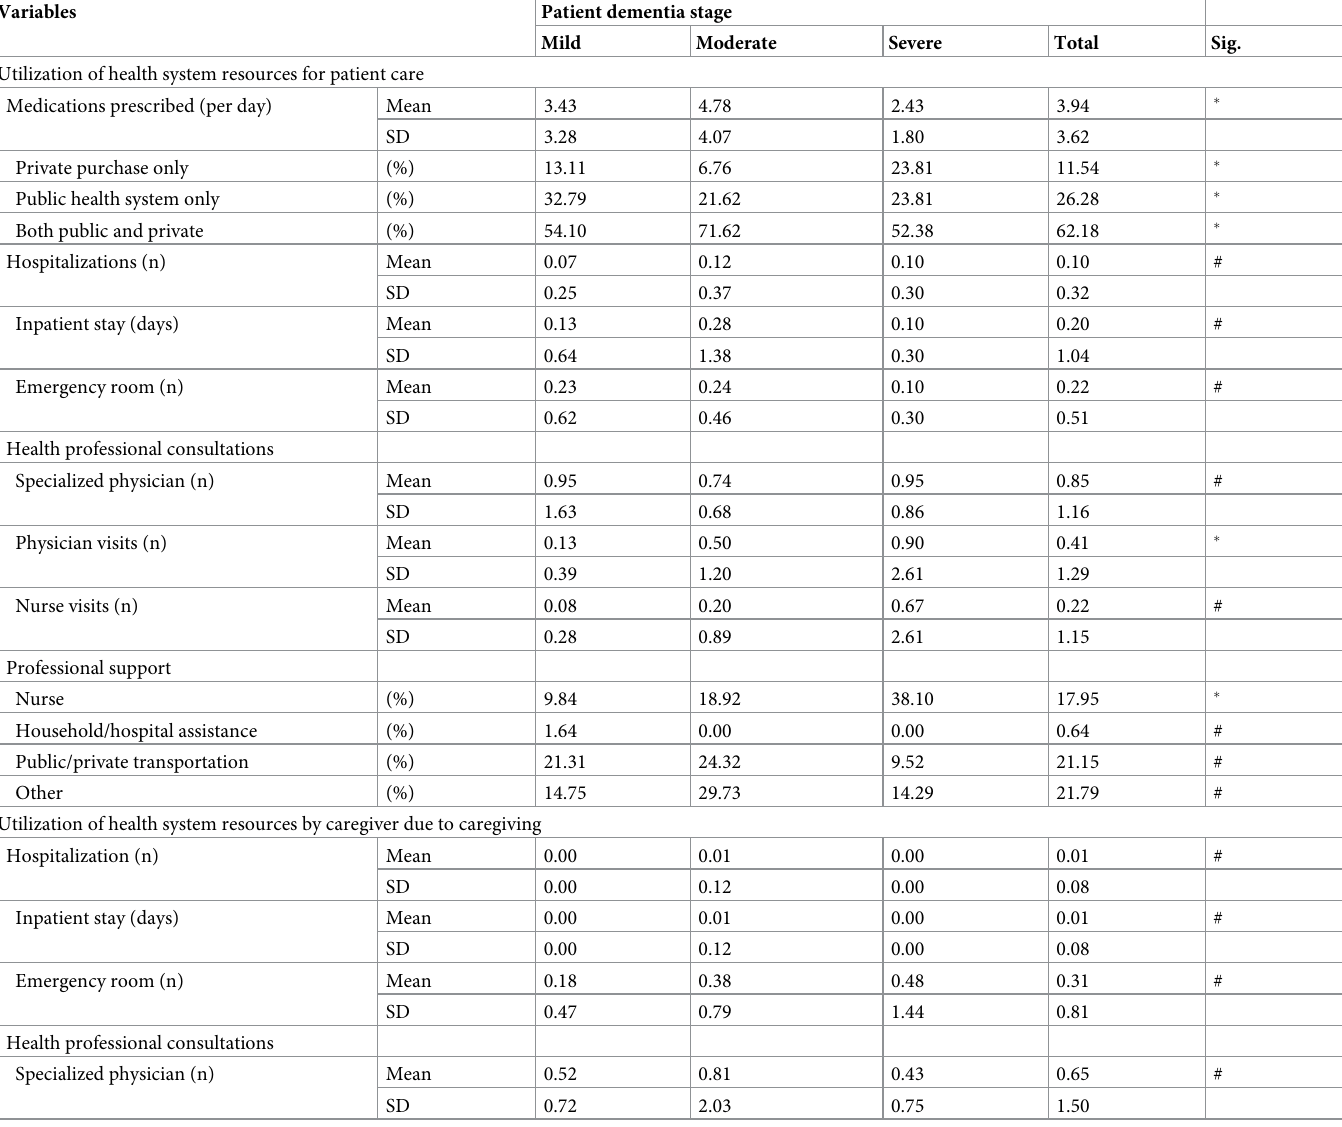
Table 3. Use of health care resources by patients with dementia and respective caregivers, according to patient FAST category, Brazil, 2016.